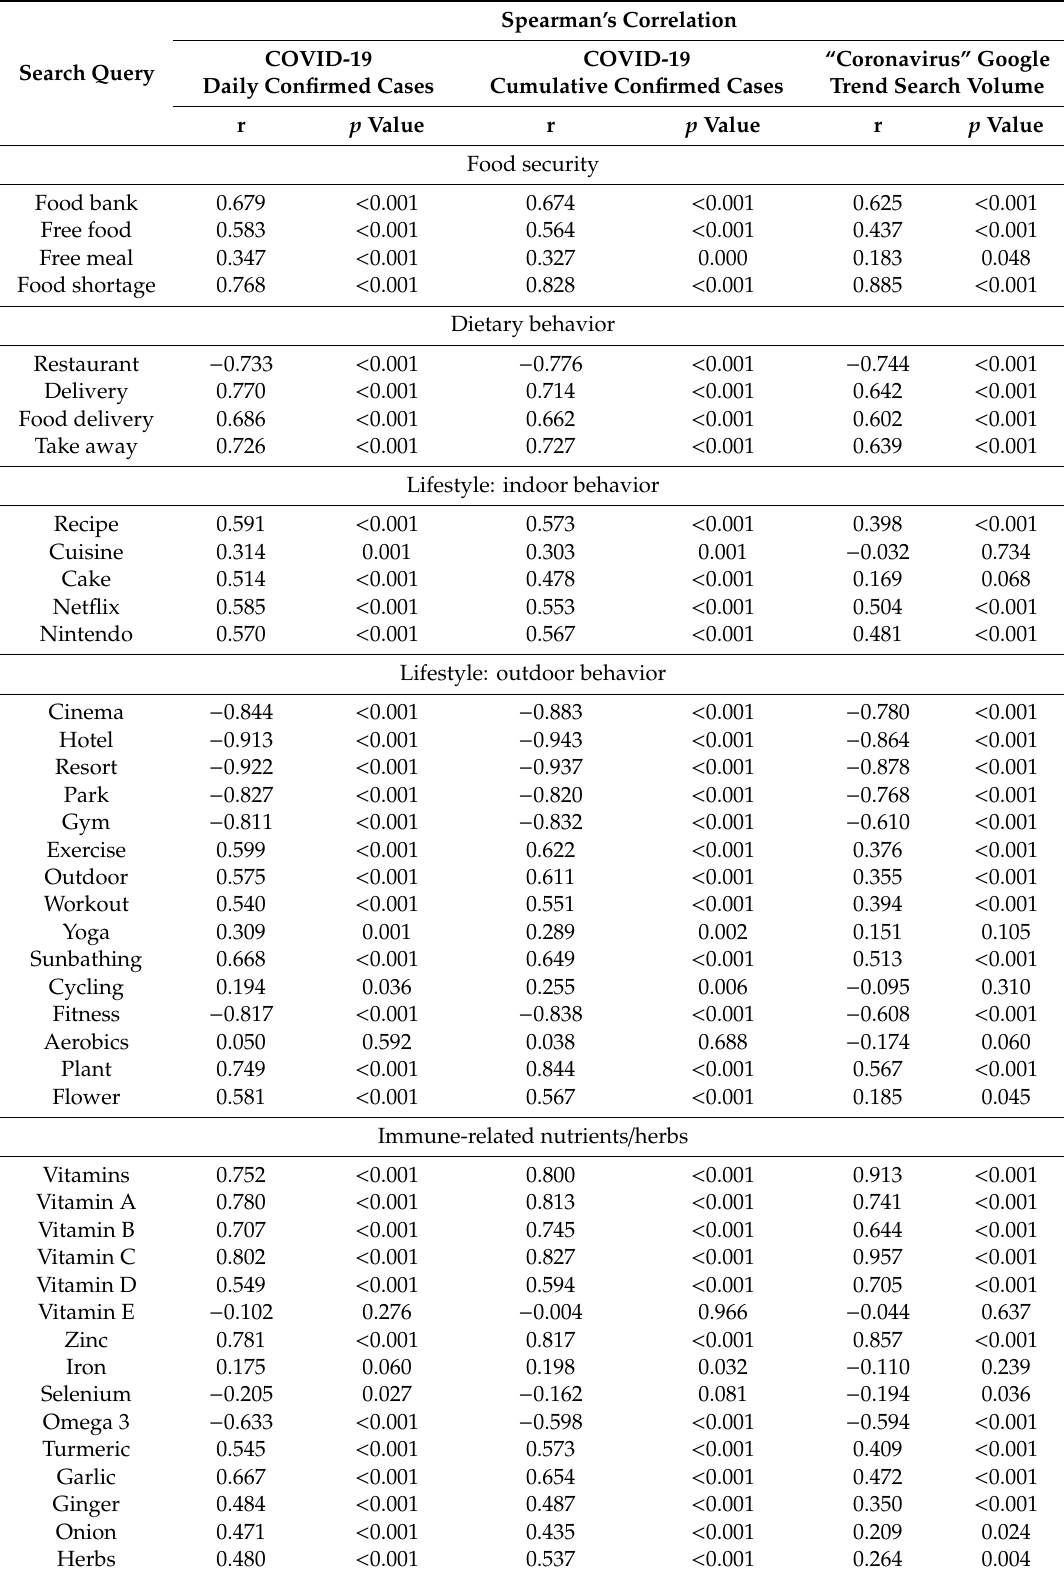
Table 1. Spearman’s correlation coe ffi cients of dietary and lifestyle behavior-related search terms and daily confirmed COVID-19 cases, cumulative COVID-19 cases, and coronavirus Google Trends